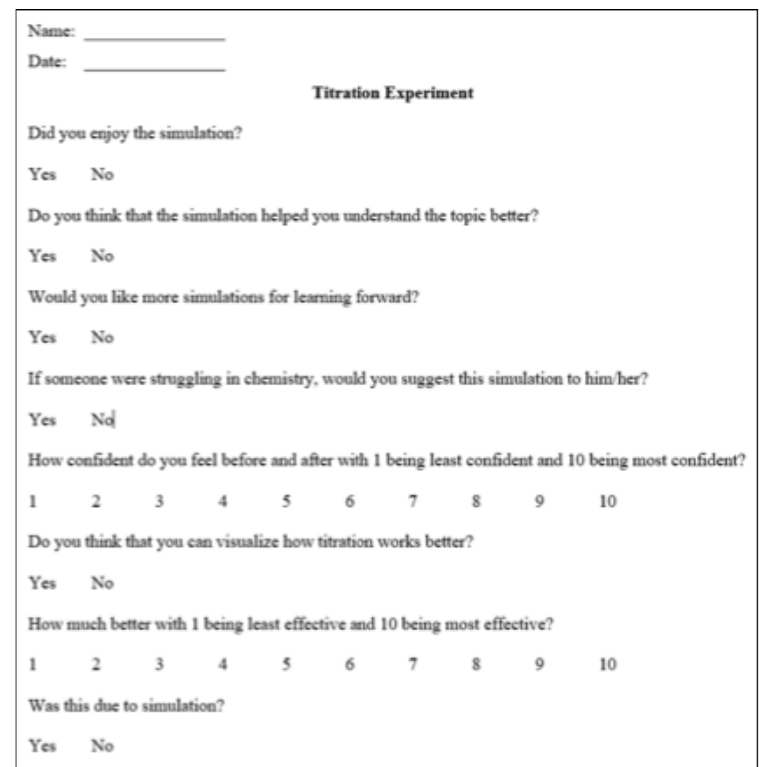
Figure 5. Student survey for the Titration experiment